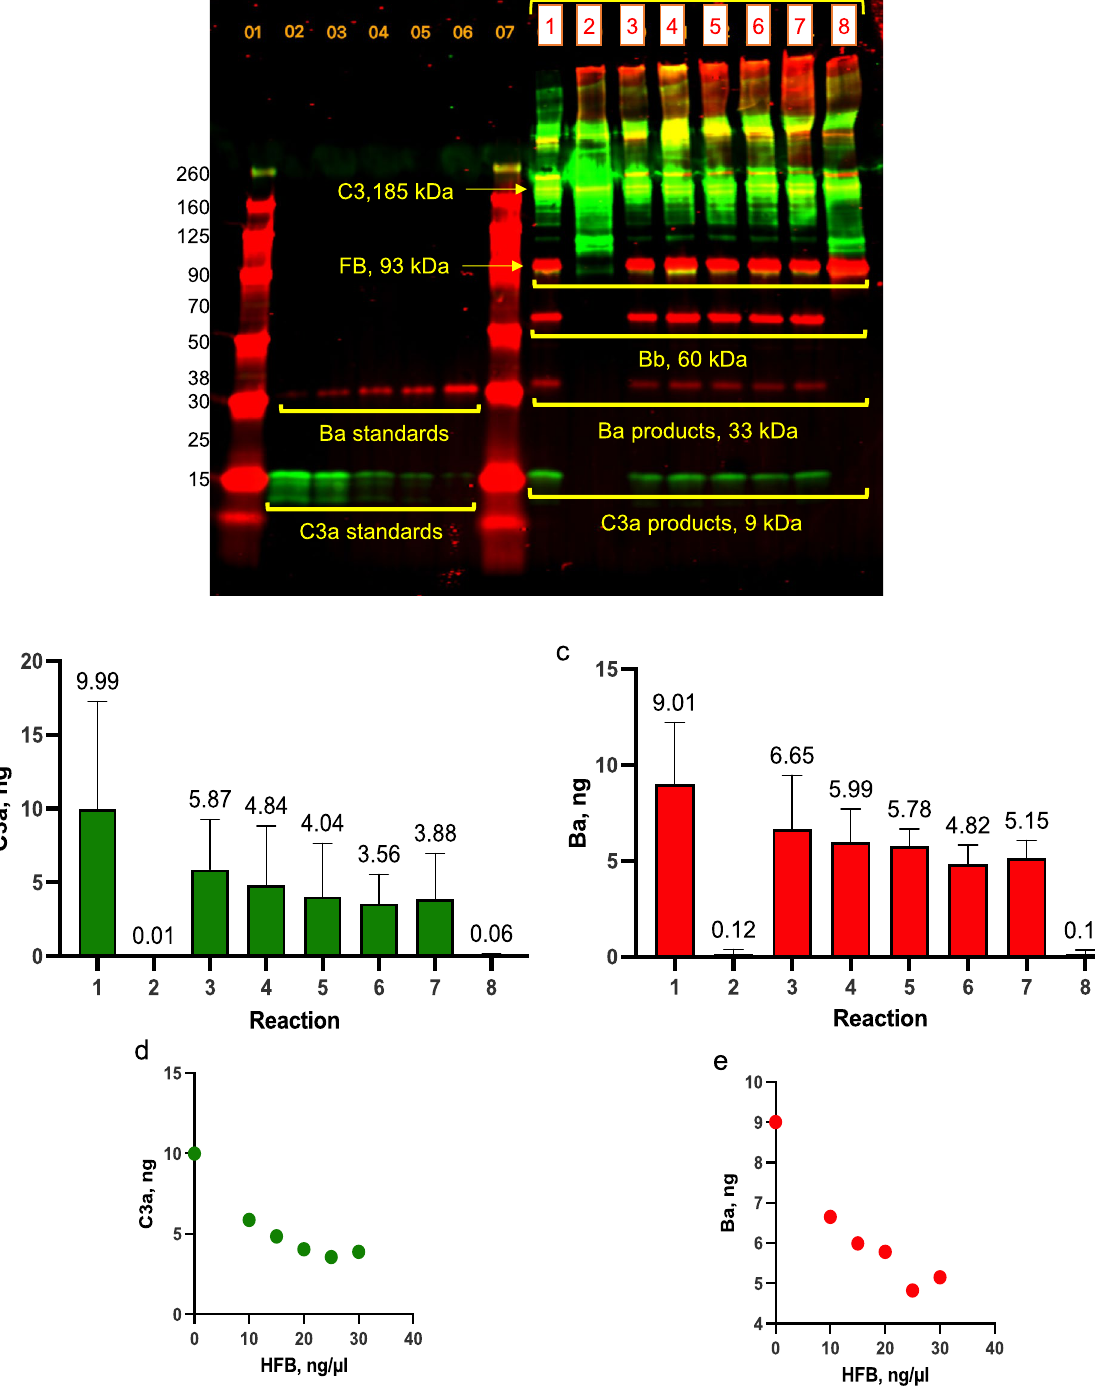
Figure 1. AP activation was reduced by addition of heat-inactivated FB. Levels of C3a and Ba, generated in AP reactions containing purified proteins with increasing amounts of HFB, were measured by quantitative Western blot analysis. Reactions, labeled with boxed numbers 1–8, consisted of: (1) 10.4 ng/µl FB + C3 + FD (without HFB); (2) 10.4 ng/µl HFB + C3 + FD (without FB); (3) 10.4 ng/µl HFB + 10.4 ng/µl FB + C3 + FD; (4) 15.6 ng/µl HFB + 10.4 ng/µl FB + C3 + FD; (5) 20.8 ng/µl HFB + 10.4 ng/µl FB + C3 + FD; (6) 26 ng/µl HFB + 10.4 ng/µl FB + C3 + FD; (7) 31.2 ng/µl HFB + 10.4 ng/µl FB + C3 + FD; and (8) 10.4 ng/µl HFB + 10.4 ng/µl FB + C3, without FD. C3 concentration is 60 ng/µl and FD is 0.07 ng/µl in each reaction, except for reaction 8. ( a ) Representative blot of merged detection of C3/C3a using rabbit anti-C3a + donkey anti-rabbit IRDye-800 (green); and FB/Bb/Ba using goat anti-FB + donkey anti-goat IRDye- 680 (red). C3a and Ba standards are in lanes 2–6, and protein ladders are in lanes 1 and 7. Graphs of reaction ( b ) C3a levels; and ( c ) Ba levels are means plus SD from 3–5 experiments. Values were not statistically different by 1-way ANOVA with Tukey’s multiple comparisons test. ( d , e ) Correlation plots of HFB concentrations and generated C3a, r 2 = 0.9224 ( d ); and Ba, r 2 = 0.9509 ( e ). Pearson’s coefficients of determination (r 2 ) were calculated for HFB concentrations from 0 to 26